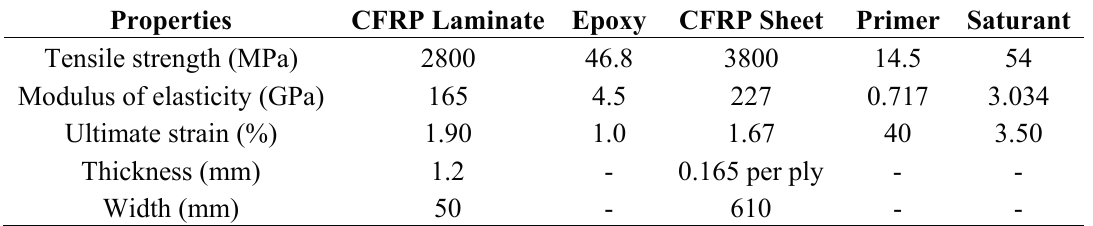
Table 1. Manufacturers’ specified properties of the carbon fiber reinforced polymer (CFRP) composites, primer and epoxy used in the current